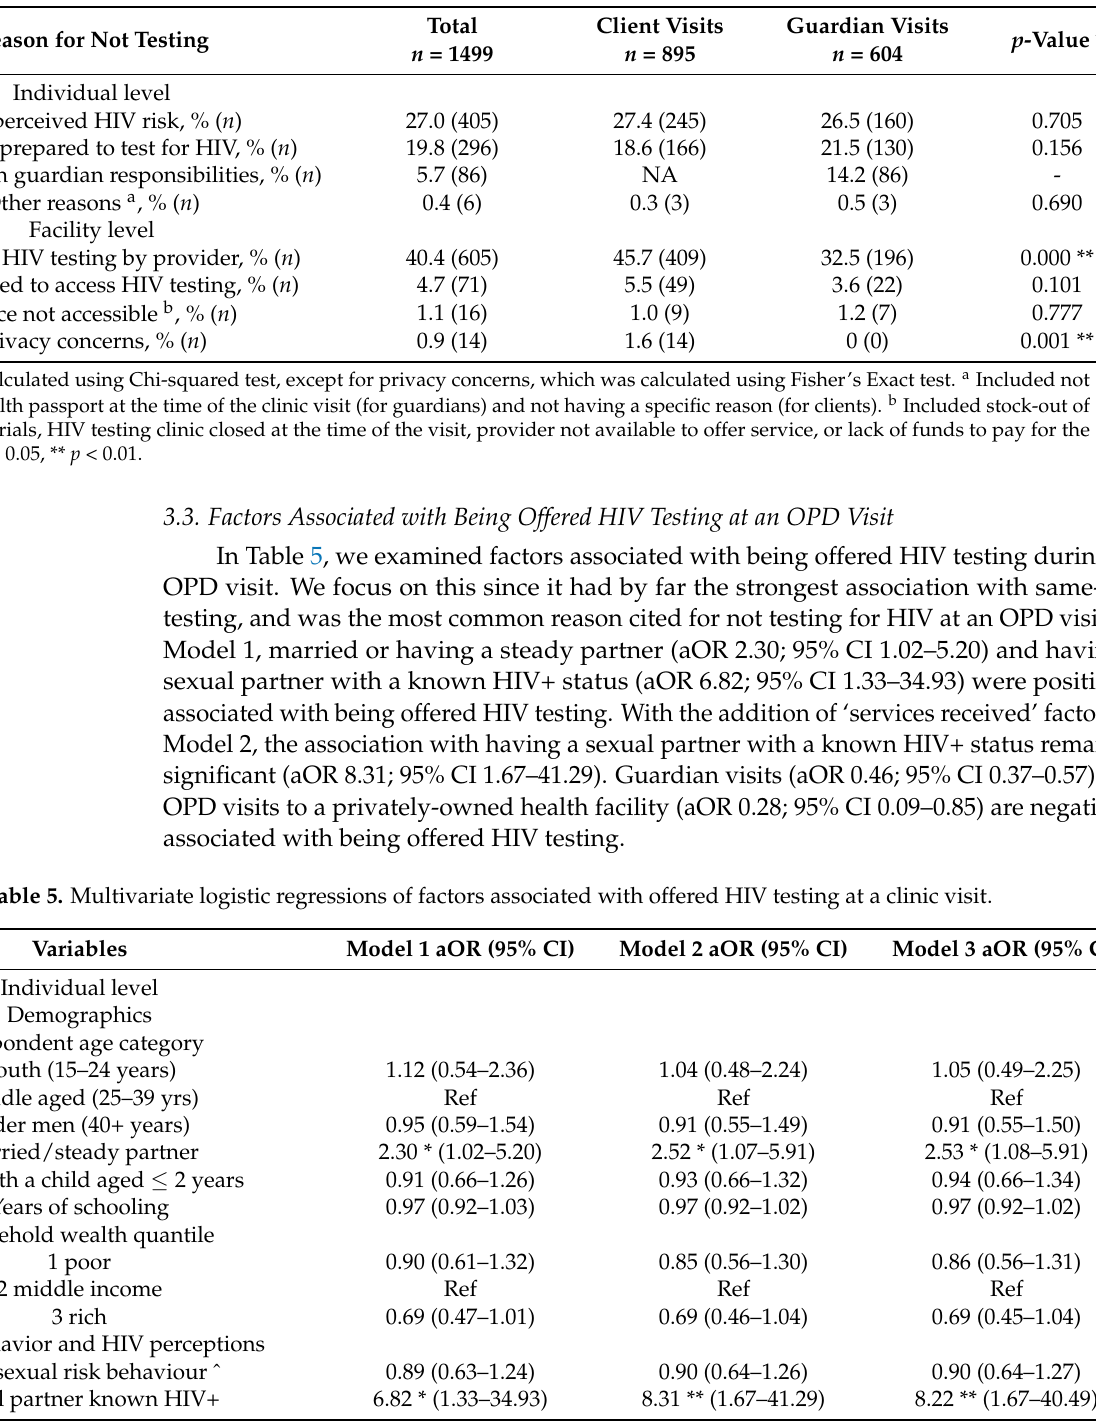
Table 4. Reasons for not testing for HIV during an OPD visit ( n = 1499).